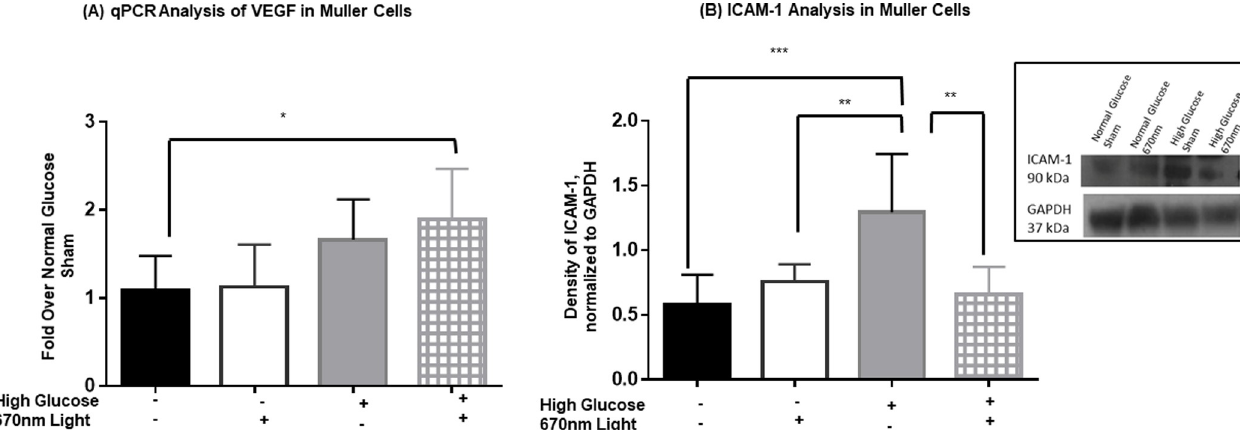
Fig 5. 670nm PBM suppresses downstream mediators of NF κ B signaling. Bar graph representing rMC-1 cells were cultured in either normal glucose (black bars and white bars) or high glucose (gray bars and hashed bars) medium for 72 hours. 670nm (white bars and hashed bars) or sham control (black bars and gray bars) was applied to the cells at 4.5 J/cm2 daily while in culture. (A) VEGF mRNA was analyzed via qPCR and normalized to actin. mRNA levels were calculated by ΔΔ Ct and normalized to Normal glucose sham. Five separate experiments were performed in duplicate. One-way ANOVA statistical analysis yielded � p = 0.0147 (B) ICAM was analyzed via western blot and normalized to GAPDH as the loading control via ImageJ. Inset includes a representative western blot image. Six separate experiments were performed, and one-way ANOVA analysis yielded � p < 0.05, �� p < 0.01, ��� p < 0.001.